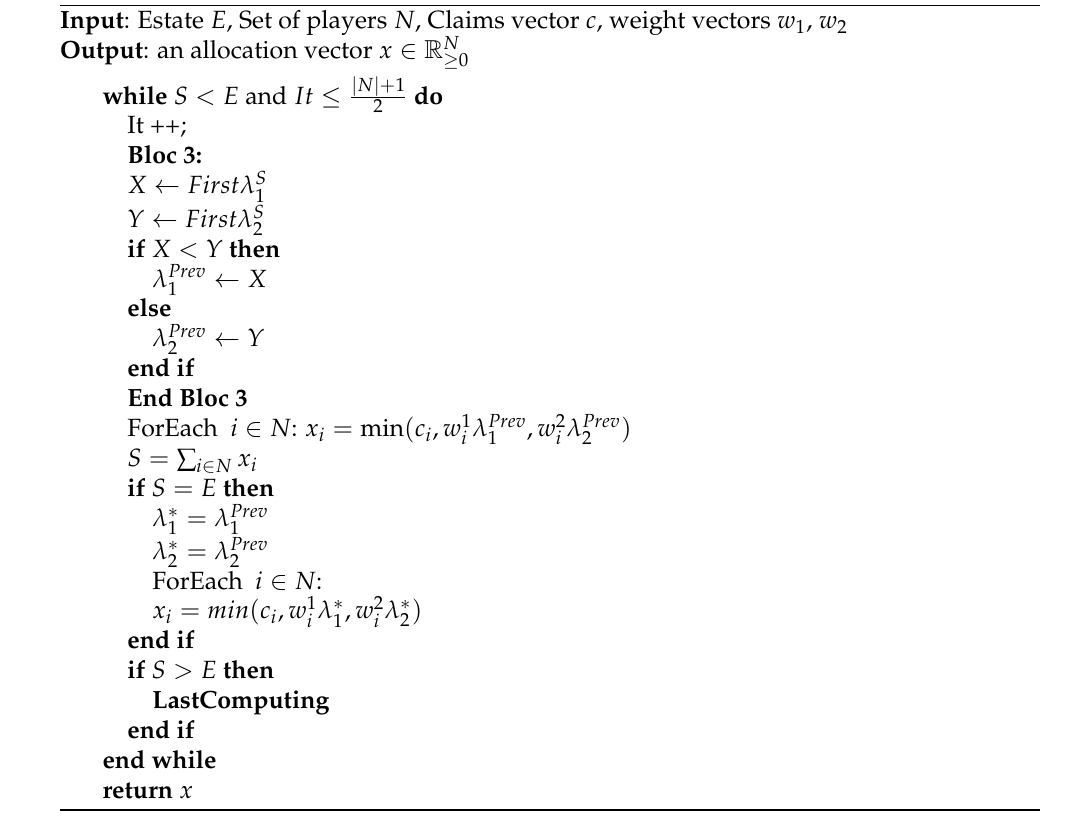
Algorithm A2 Estate is higher than allocations’ sum